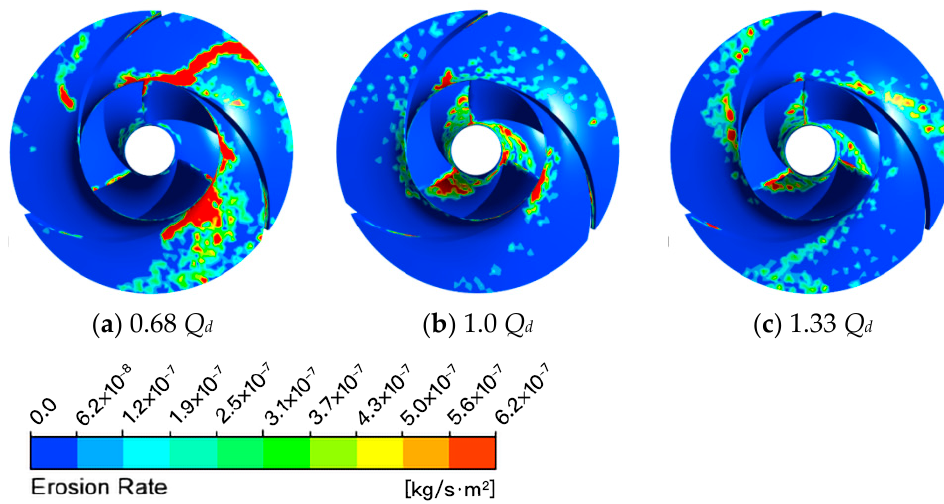
Figure 17. Wear distribution on the impeller surface.